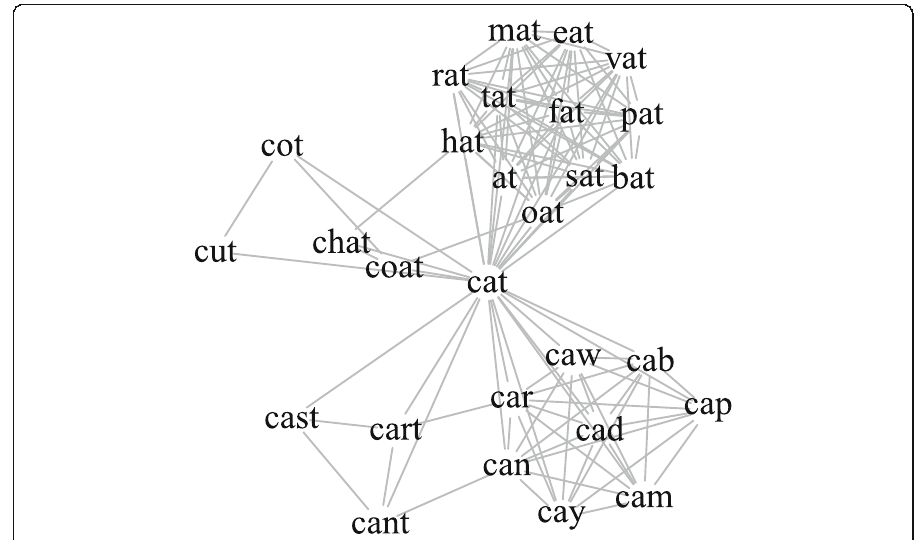
Fig. 1 The orthographic structure of the ego network of the word ‘ cat ’ . An undirected and unweighted edge was placed between two words that differed by a Levenshtein edit distance of 1 (i.e., whether the first word could be transformed into the second via the substitution, addition, or deletion of one